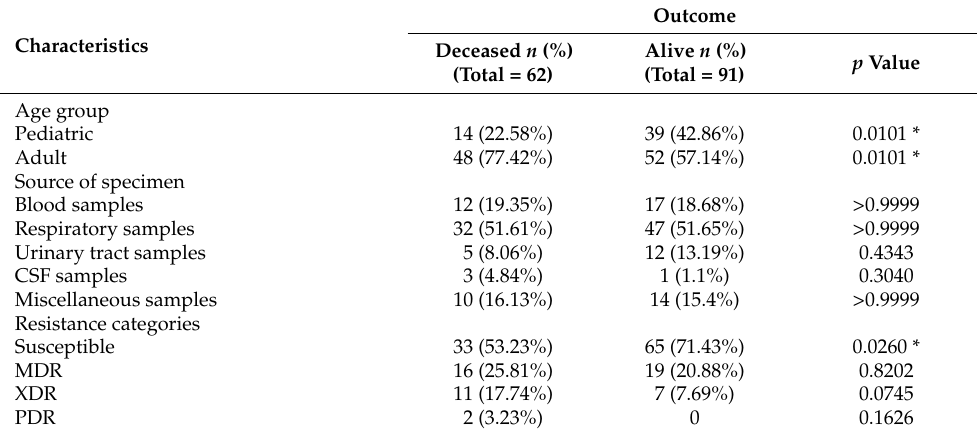
Table 2. Factors associated with mortality of ICU patients infected with E. cloacae